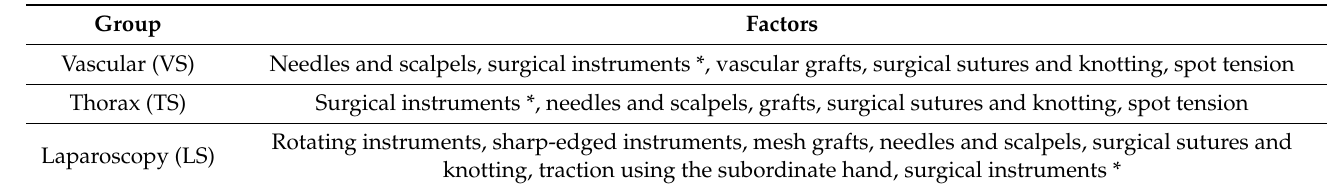
Table 4. Factors associated with the risk of glove